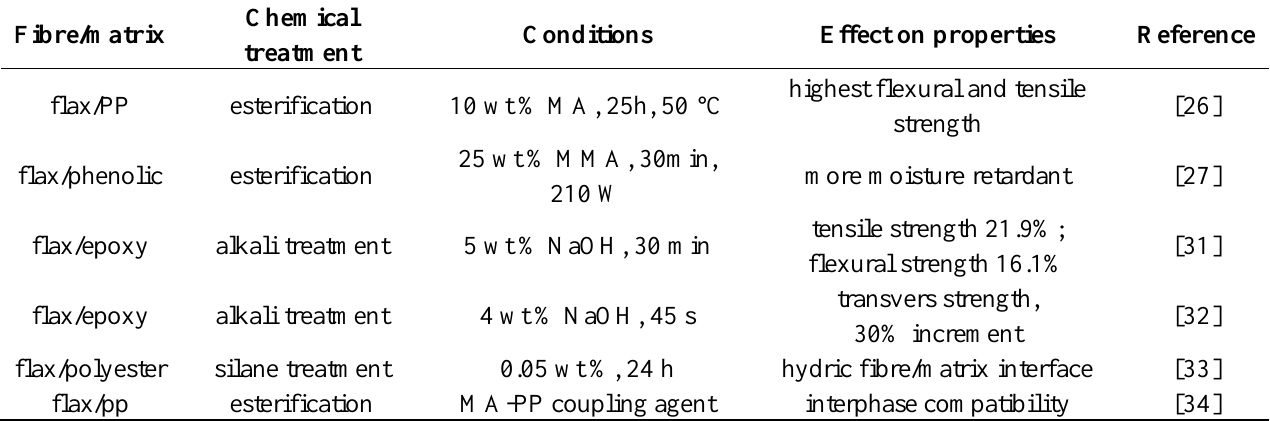
Table 4. Different treatments of flax-reinforced